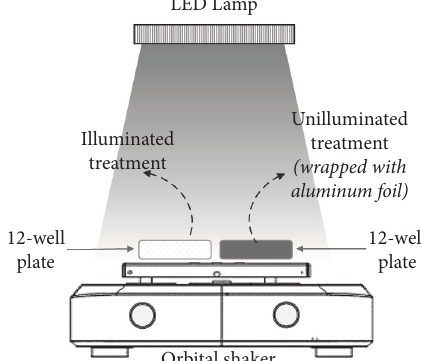
Figure 2: Schematic illustration for the set-up of photodynamic experiment. The suspensions containing sensitizer and liquid culture of bacteria were transferred onto 12-well plate and posi- tioned on the orbital shaker (100rpm, 30min, at 18 ± 3 ° C) under the LED lamp (65.2Wm − 2 ). The equivalent samples for unil- luminated treatment were put in an identical plate wrapped with aluminum foil.